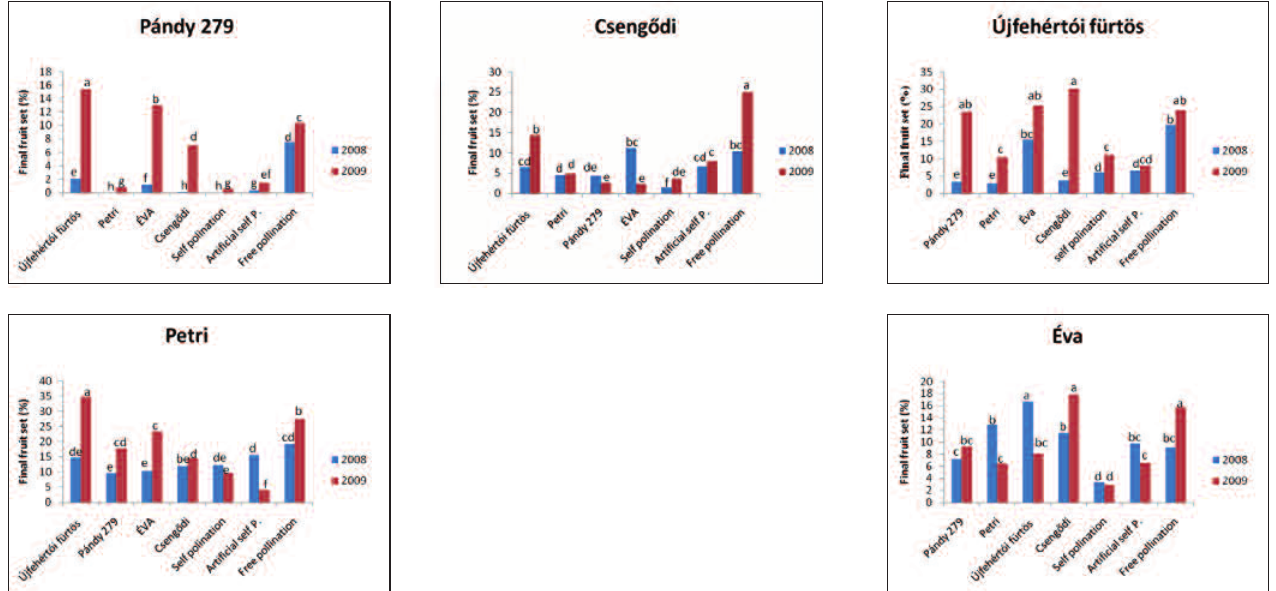
Fig 1: Comparison of fruit set percentage of sure cherry cultivars following natural self-pollination, free-pollination and cross-pollination. Columns followed by a different character indicate significant difference using Duncan’s multiple range test